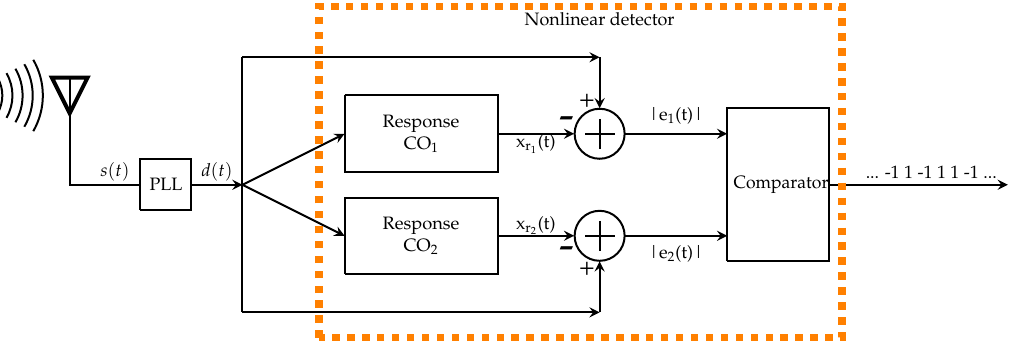
Figure 5. Proposed architecture for the communication